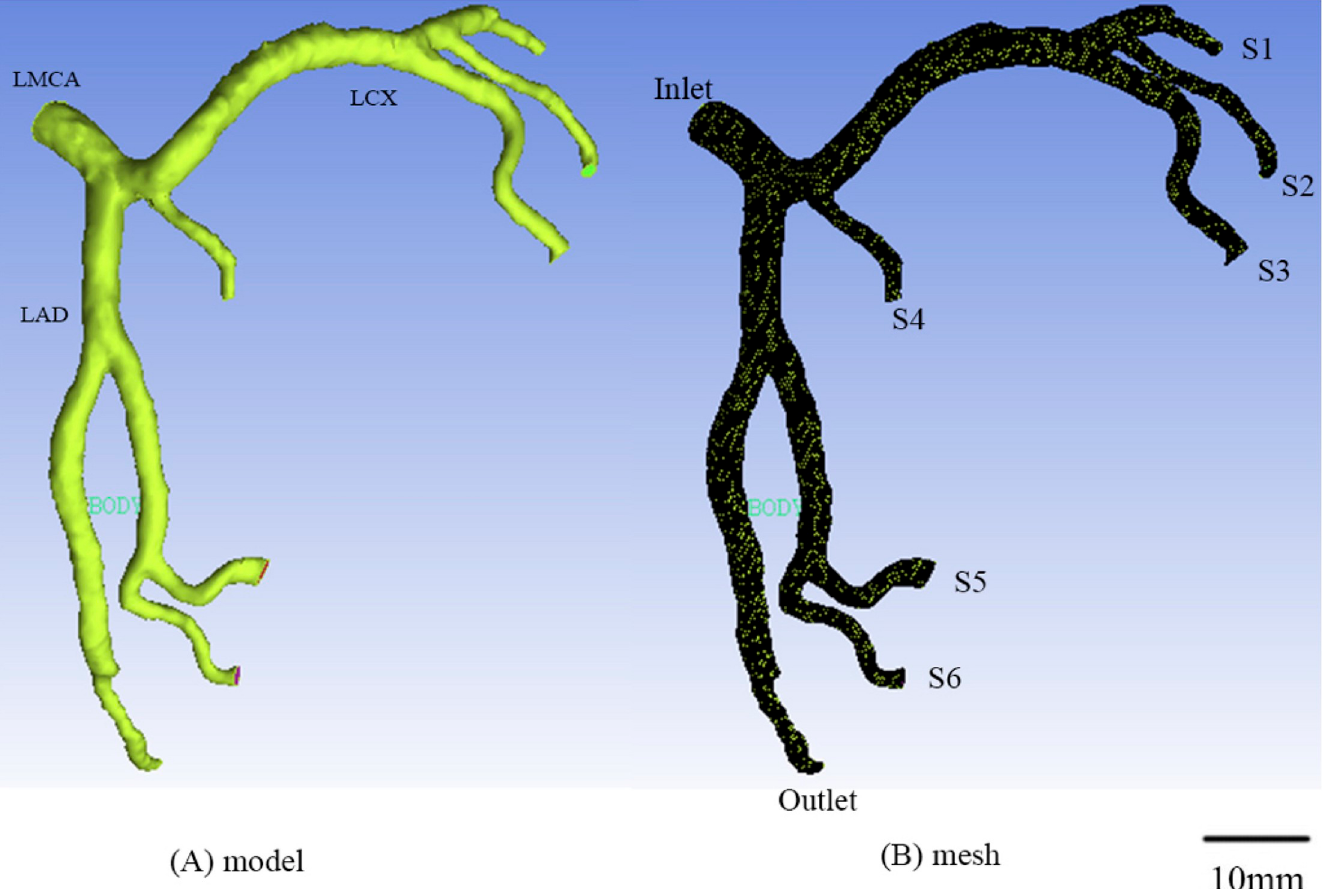
Fig 1. Geometrical model reconstructed from CTA (A) and computational meshes (B) in the epicardial LMCA tree of a representative patient.